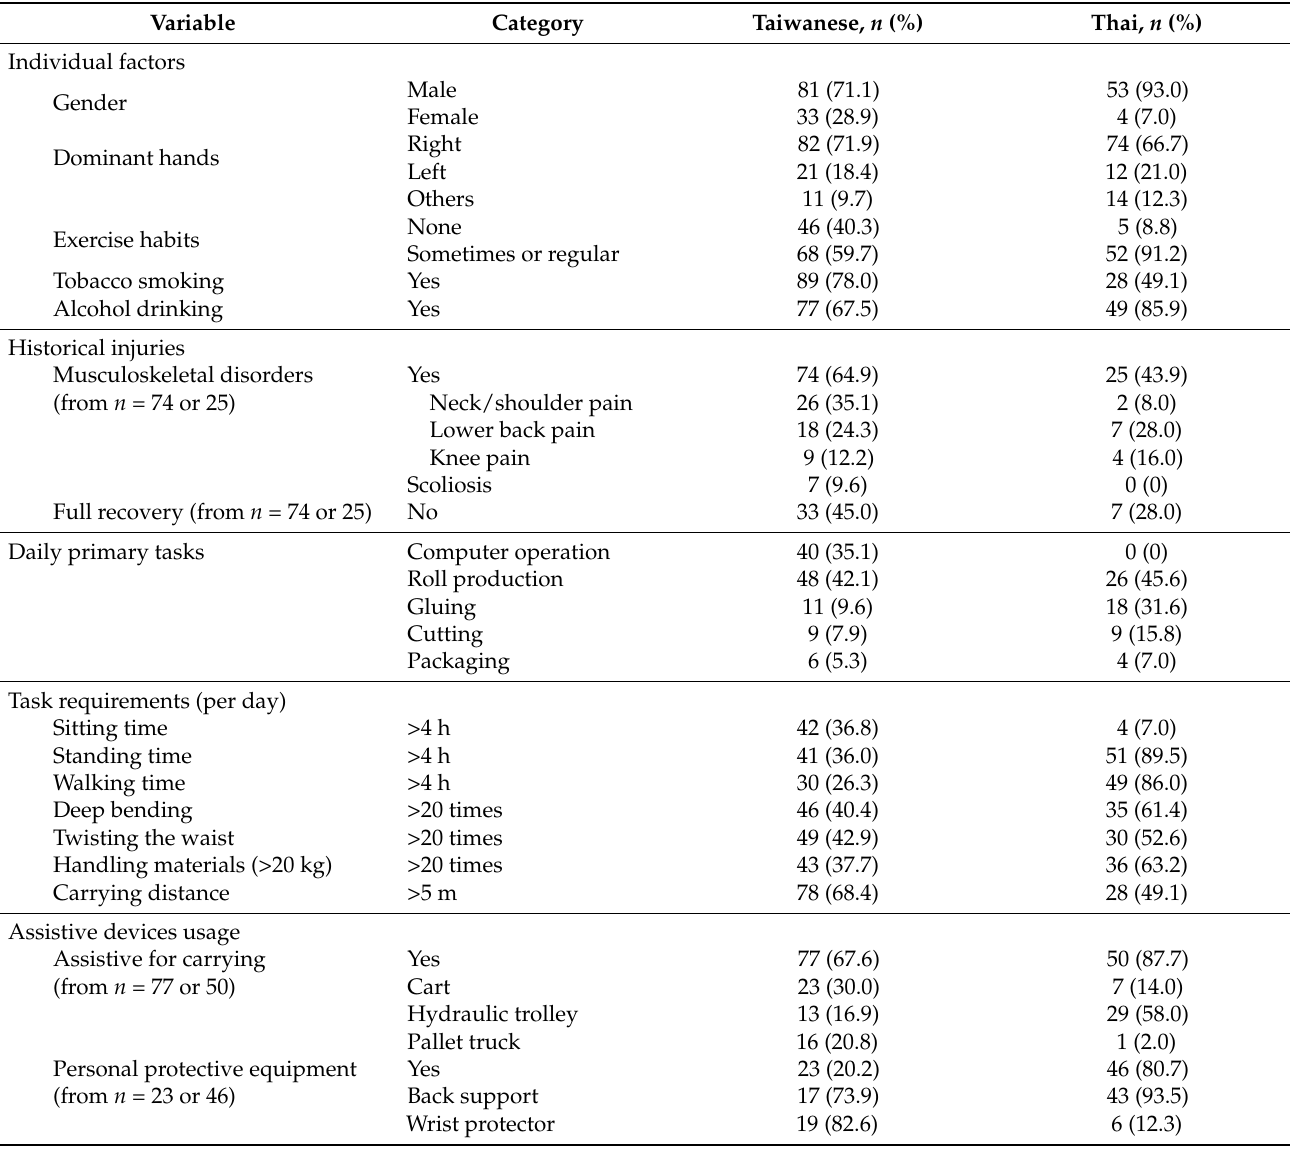
Table 2. Basic information and task characteristics of the 114 Taiwanese and 57 Thai